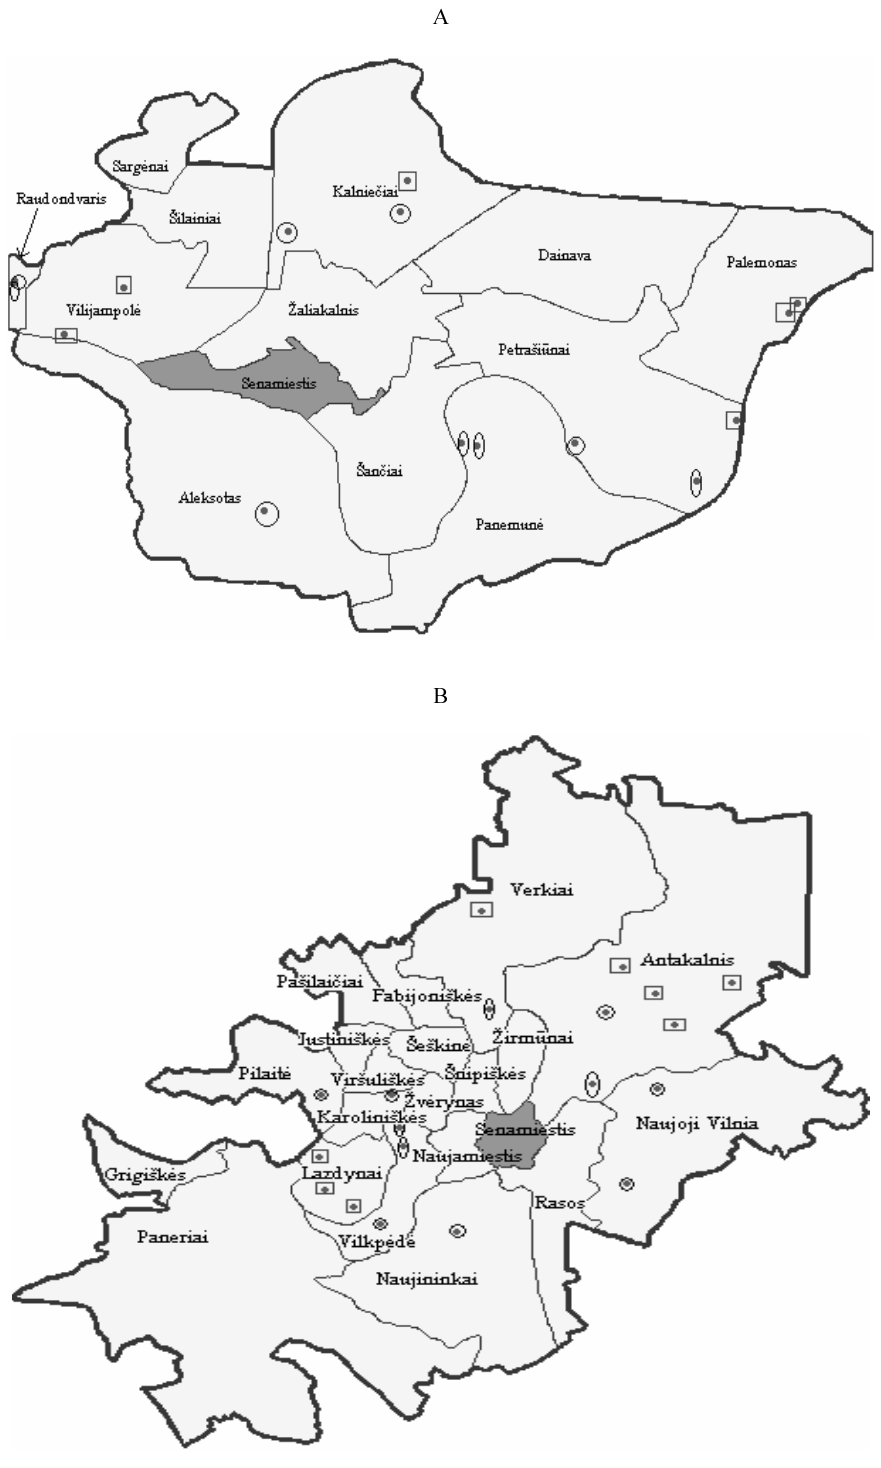
Fig. 1. Distribution of sample plots in Kaunas (A) and Vilnius (B). Sample plots of 60–70 year old pines are marked by circles; sample plots 80–90 year old pines by rectangles; sample plots in ellipses – 160–180 year old